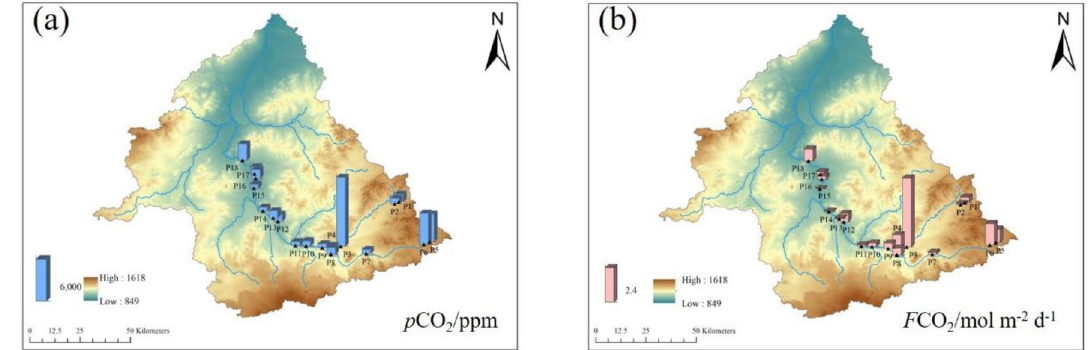
Figure 7. Spatial variation of p CO 2 ( a ) and F CO 2 ( b ) in the Xilin River in 2018 (generate by Arcgis 10).